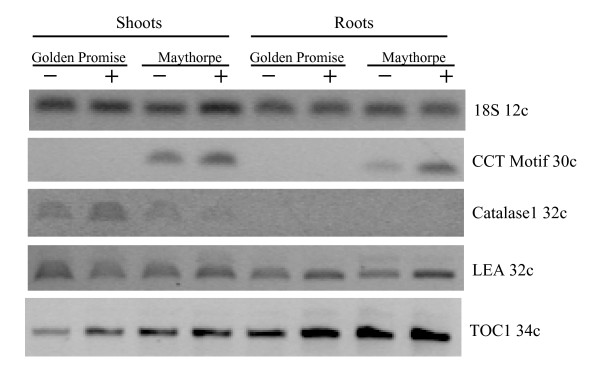
RT PCR validation of some key genes. Expression level of some genes discussed in the current study were validated by RT-PCR for shoot and root tissues. The (-) indicates control unstressed samples and (+) indicates salinity stressed samples.